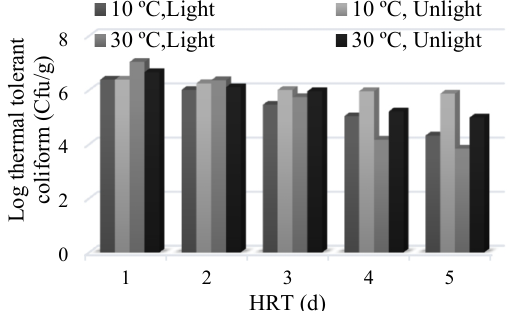
Fig. 1. Changes in thermophilic coliform in FAS under different conditions (pH < 7)